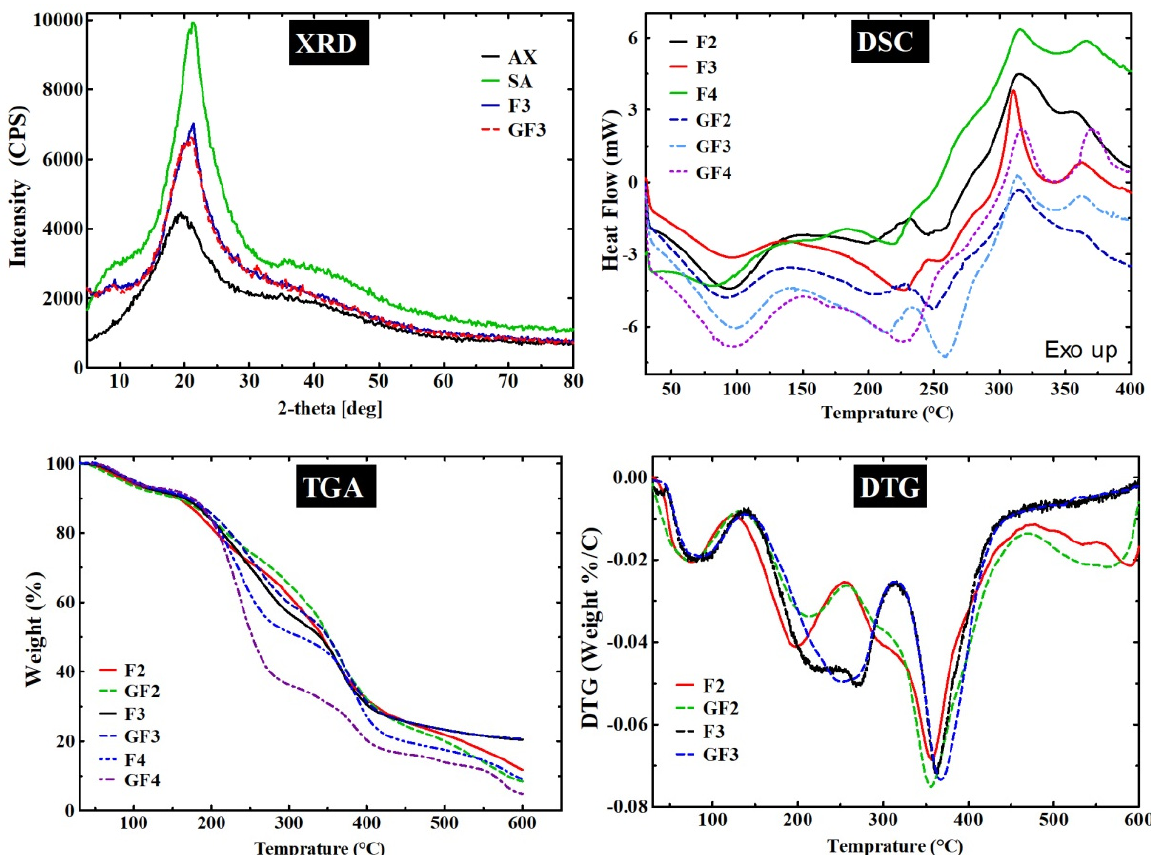
Figure 4. XRD, DSC, TGA and DTG analyses of the AXSA films.